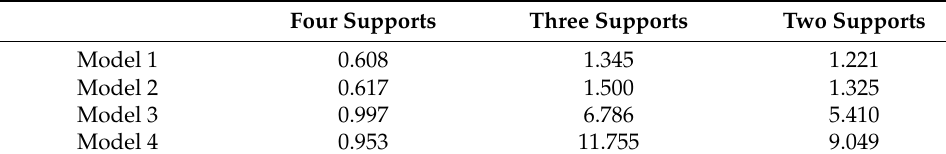
Table 1. The maximum capacity ratios for different FE models.